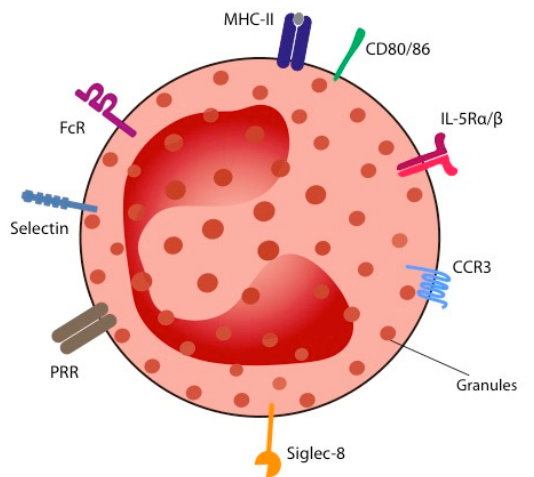
Figure 2. Structure of the human eosinophil. Eosinophils can be characterised by their surface markers and by their intracellular content. Cell-surface markers are: adhesion molecules (selectins) allowing for adhesion and endothelial transmigration; chemokine receptors (CCR) and chemotactic factors allowing for the attraction and local activation of eosinophils; cytokine and growth factor receptors (e.g., Interleukin-5 Receptor alpha subunit (IL-5R α )); complement receptors; immunoglobulin recep- tors (e.g., FcR); inhibitory receptors (e.g., Sialic acid-binding immunoglobulin-like lectin-8 (Siglec-8)) and pattern recognition receptors (PRR), e.g., Toll-like receptors whose activation is triggered by alarmins (Pathogen-associated molecular patterns (PAMPs) in case of infection and Danger-associated molecular patterns (DAMPs) in case of